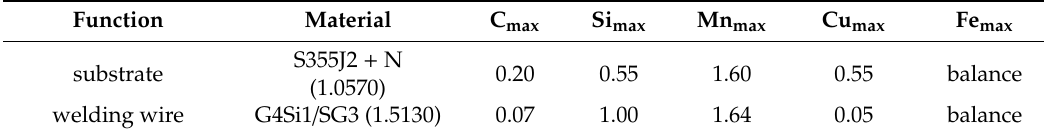
Table 1. Chemical composition of substrate and welding wire (%).